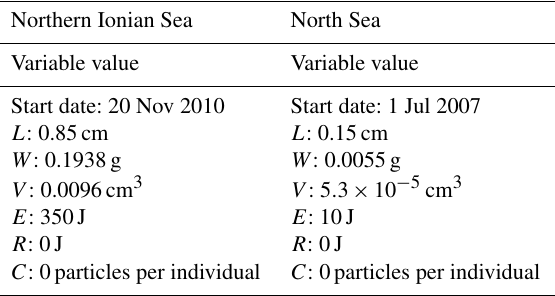
Table 5. Dynamic energy budget-accumulation model: initial